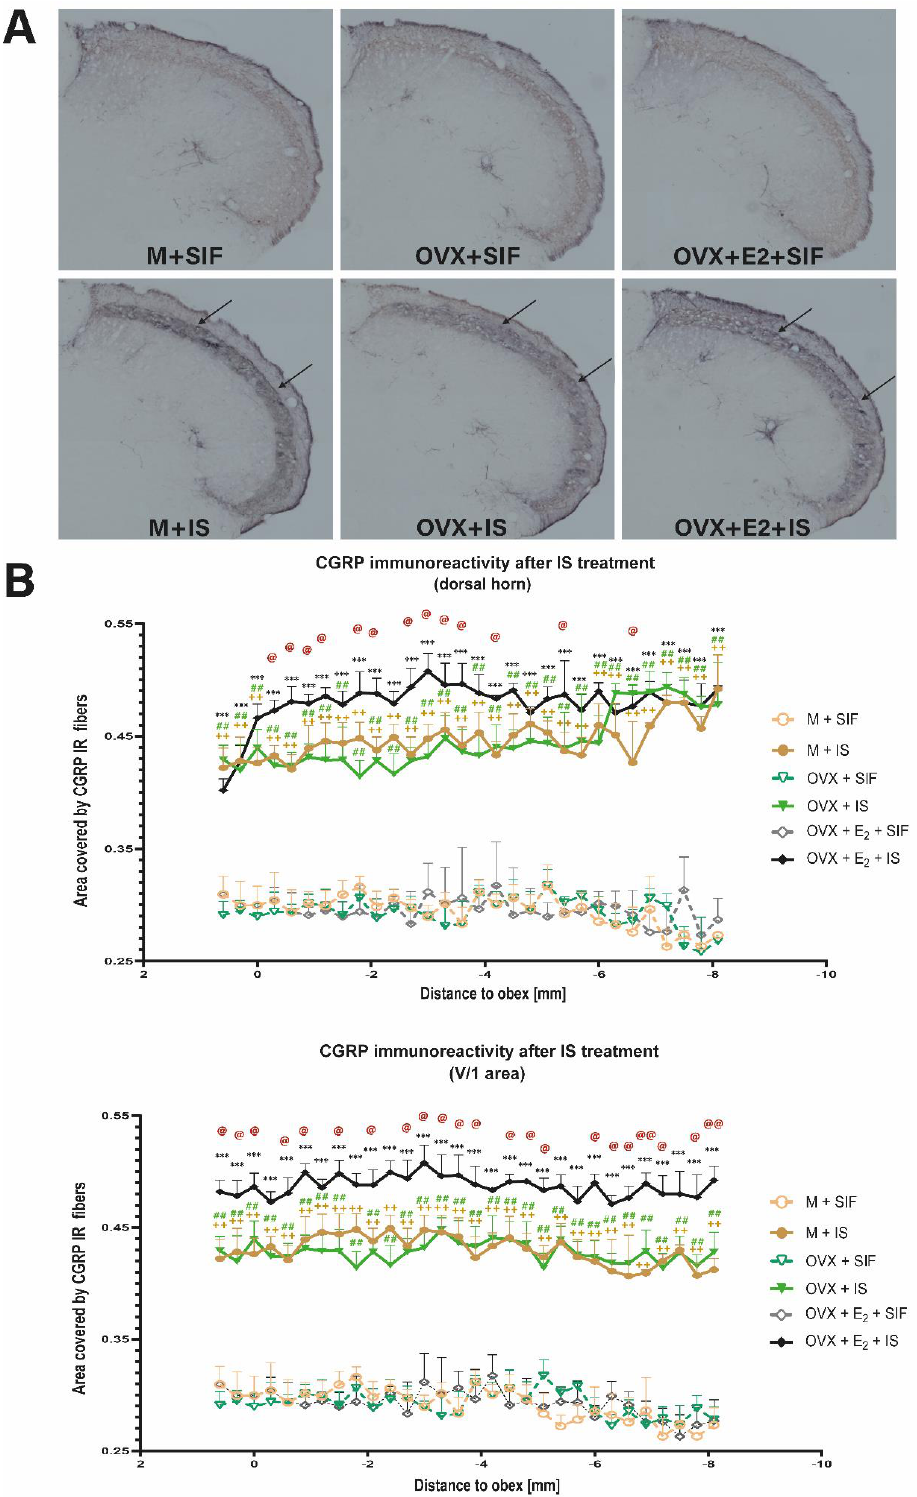
Figure 3. CGRP immunostaining. ( A ) Representative photomicrographs of the CGRP expression in the trigemino-cervical segments. In the IS treated groups, the CGRP staining was stronger compared to the control groups. ( B ) Statistical analysis of CGRP staining. In the IS-treated groups, the area covered by CGRP-IR fibers is significantly higher than in the control groups in the whole dorsal horn and in the ophthalmic nerve area. + means M + SIF and M + IS, # means OVX + SIF and OVX + IS, and * means OVX + E2 + SIF and OVX + E2 + IS difference. @ means M + IS and OVX + E2 + IS difference. (* p in the range from 0.05 to 0.01; ** p in the range of 0.01 to 0.001; *** p < 0.0001).